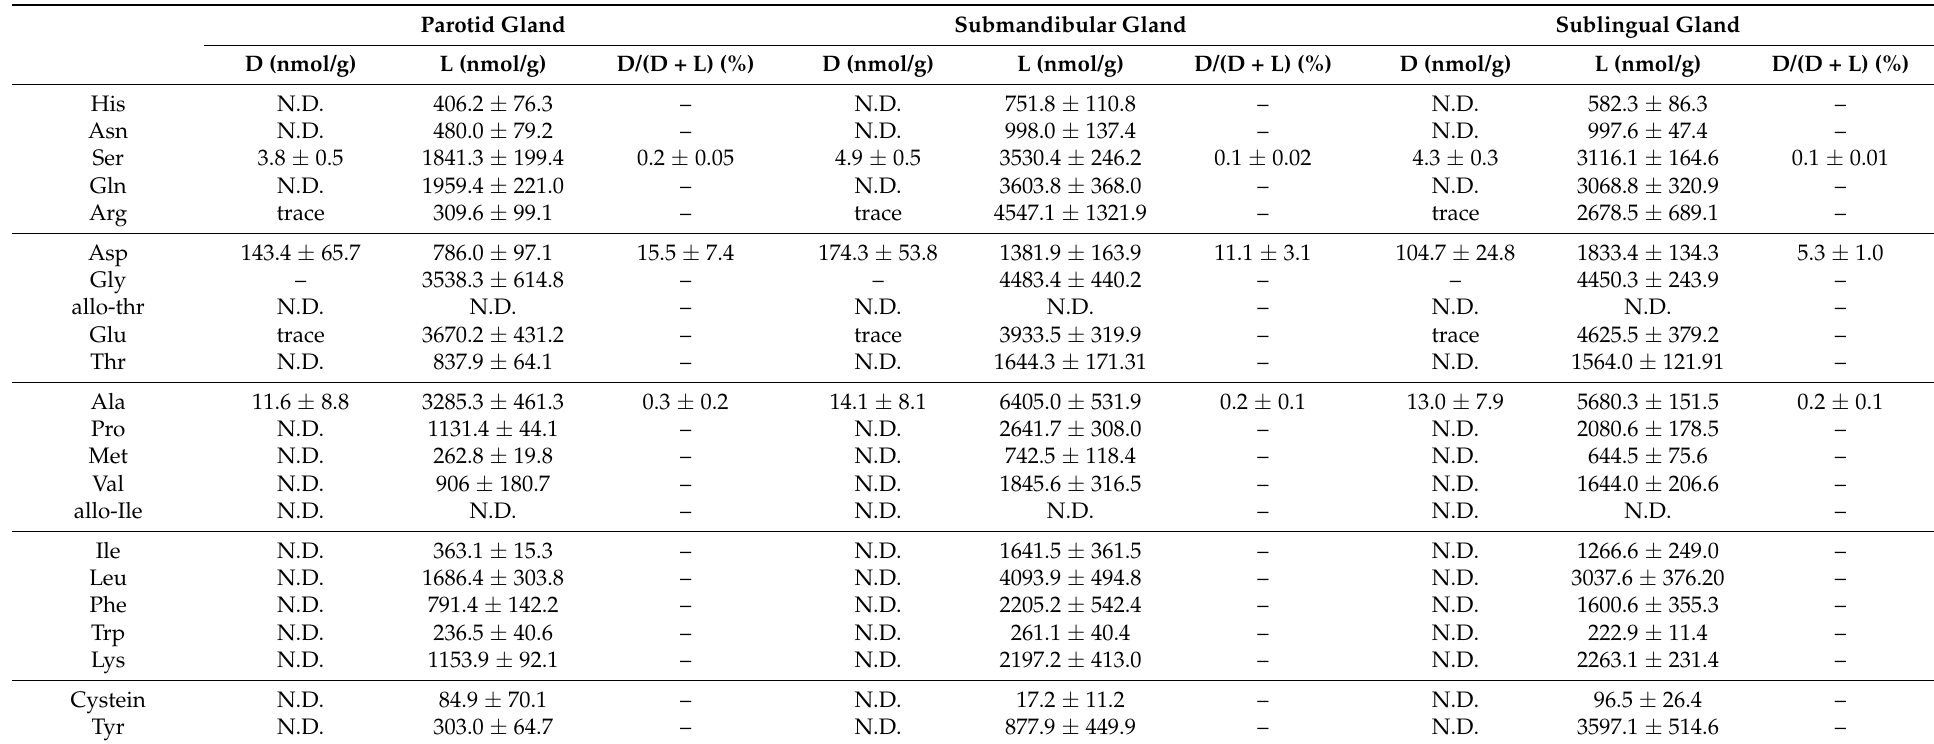
Table 1. Amino acids contents in three major salivary glands of